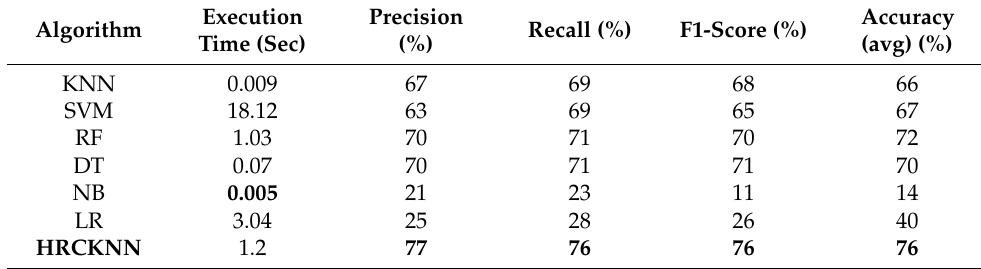
Table 6. Performance Comparison of Machine Learning Algorithms with HRCKNN. Algorithm